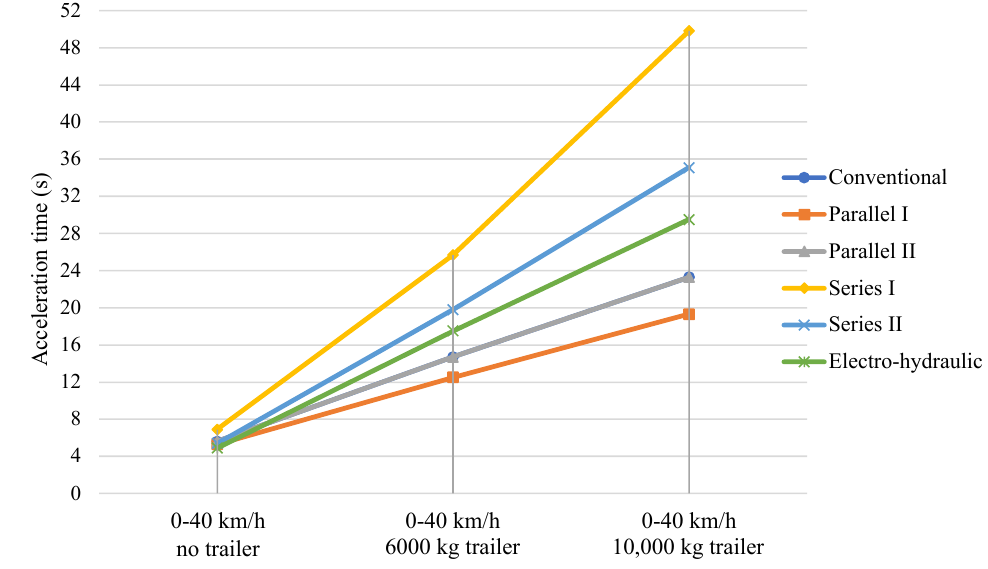
Figure 15. Acceleration performance